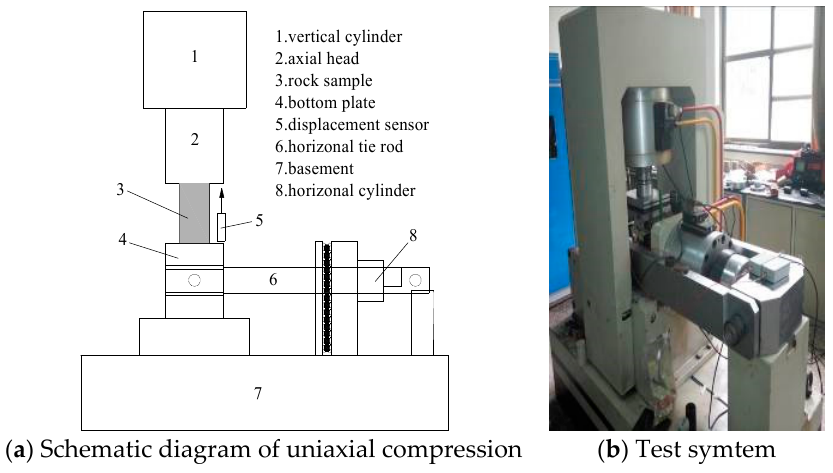
Figure 4. Electro-hydraulic servo rock test system of RMT-150B.